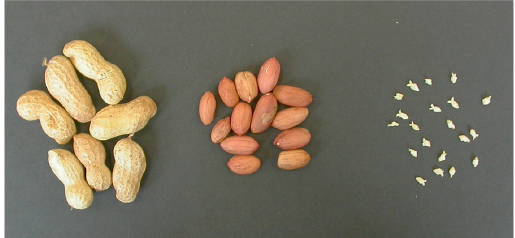
Figure 1. Peanut seeds used as plant material of the study. The figure shows pods, seeds, and embryos of Arachis hypogaea L. cv. Virginia, respectively.